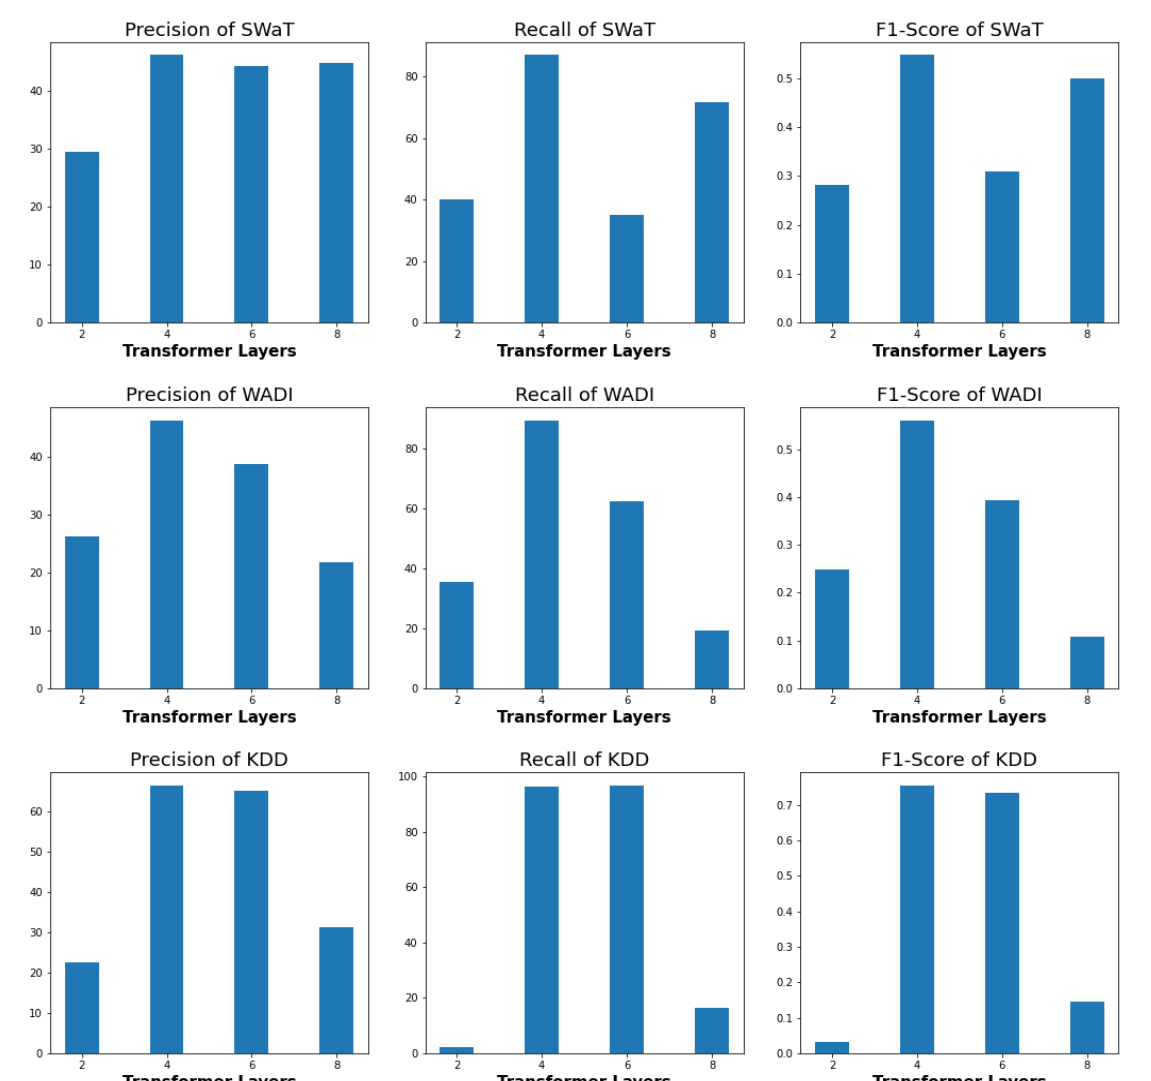
Figure 7. The variation of Precision , Recall , and F 1 with different Transformer Layers of two repre- sentative datasets, i.e., SWaT, WADI and KDDCUP99. Note that all other parameters are fixed, with the exception of the number of encoder and decoder layers, which are empirically set at 2, 4, 6, and